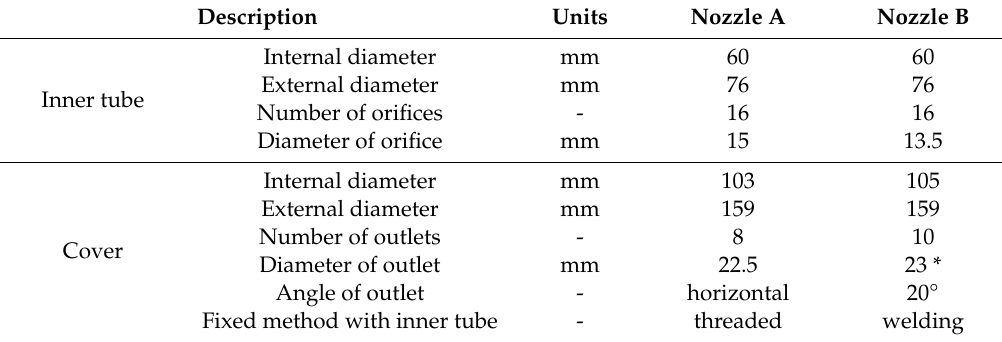
Table 1. Structure of nozzle A and nozzle B.